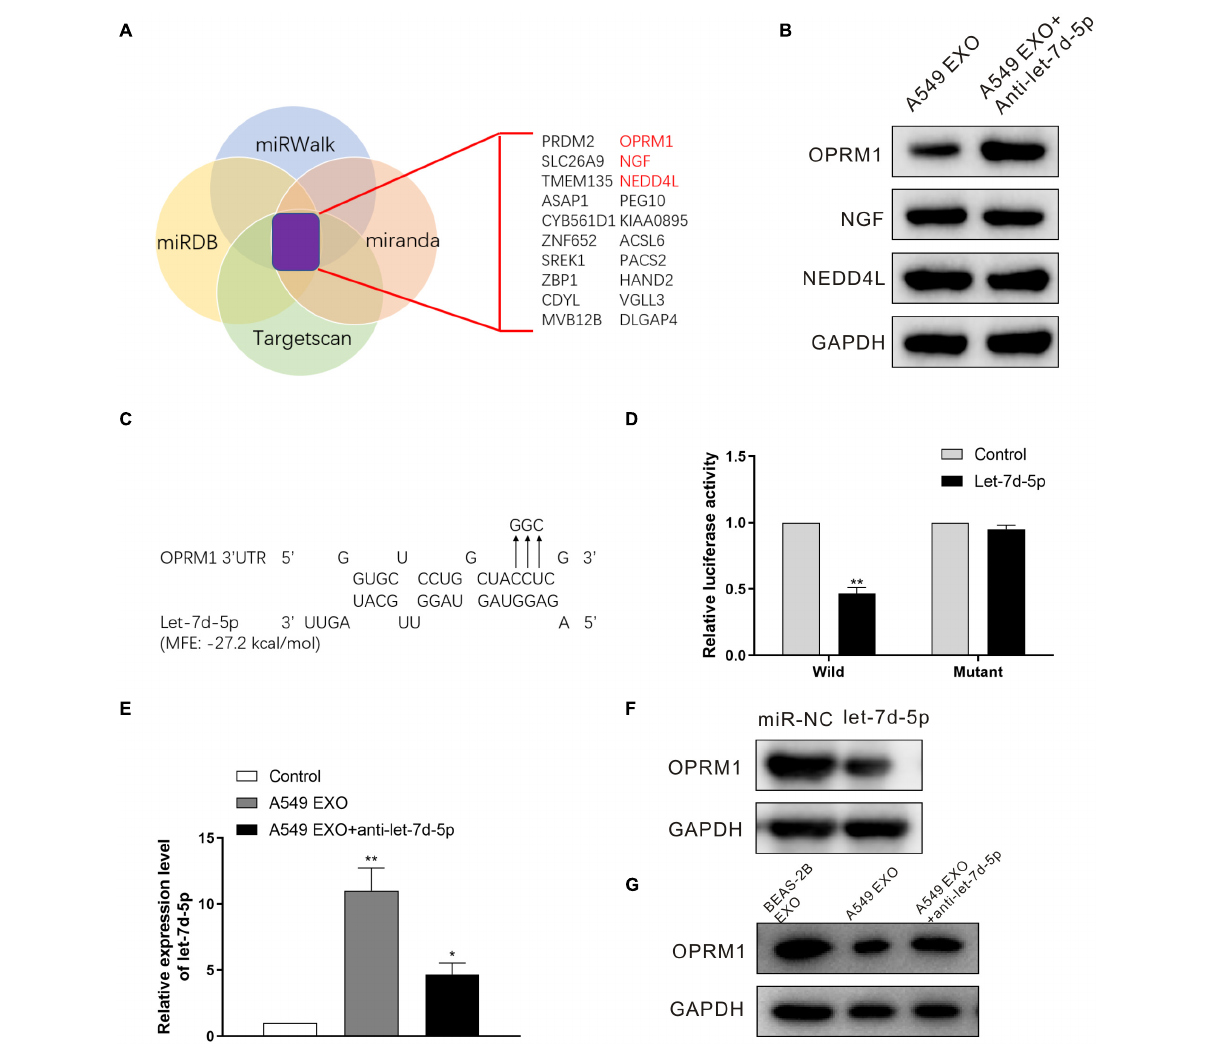
FIGURE 3 | OPRM1 is the functional target of let-7d-5p in DRG neuron cells. (A) A diagram illustrating of target genes analysis. (B) Western blotting analysis of OPRM1, NGF and NEDD4L in DRG neuron cells with A549 exosomes plus anti-let-7d-5p lentivirus. GAPDH was used as loading control. (C) Predicted consequential binding sites of let-7d-5p and OPRM1 3 (cid:48) UTR. (D) Let-7d-5p suppressed the luciferase activity of the luciferase reporters carrying OPRM1 3 (cid:48) -UTR. Both wild-type (UTR-WT) or mutant (UTR-mut) reporters were introduced into 293T cells by transfection and then incubated with the let-7d-5p mimics. ** P <